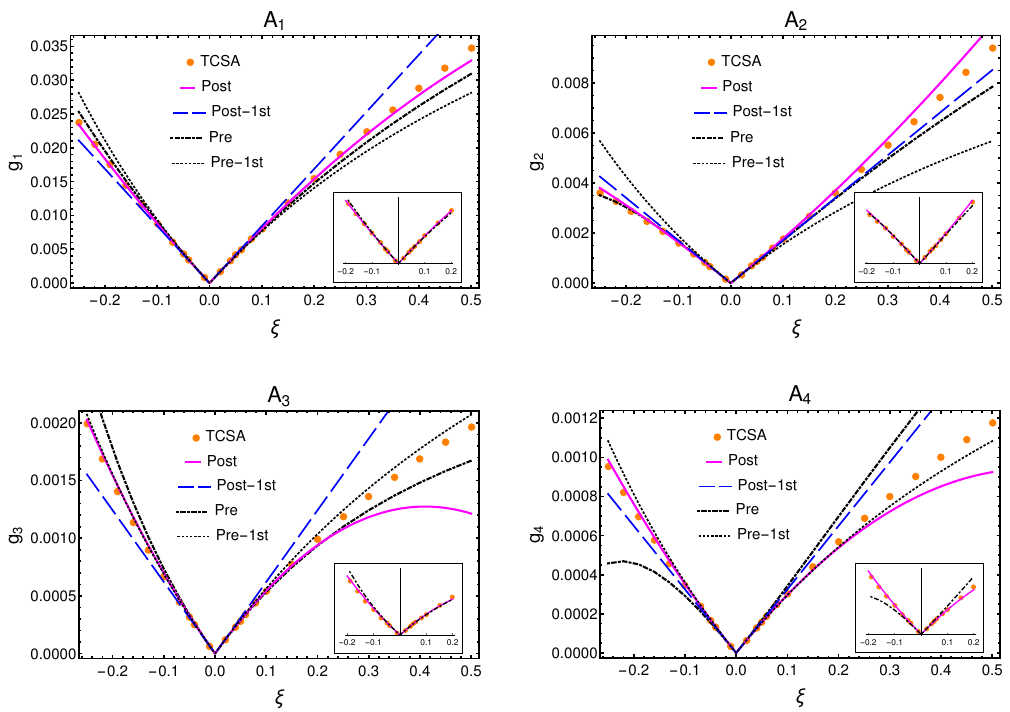
Figure 5 . Comparison between TCSA overlaps of the lightest four one-particle states and two di(cid:11)erent perturbative expansions as functions of the quench magnitude (cid:24) for quenches along the E 8 axis in volume m 1 R = 40. Dashed lines indicate the (cid:12)rst-order predictions of the post-quench expansion and continuous lines depict the sum of the (cid:12)rst two orders. The pre-quench result up to the (cid:12)rst and second order is shown in dotted and dot-dashed lines, respectively. TCSA data is shown by dots. Inset: second order results vs. TCSA for j (cid:24) j < 0 :